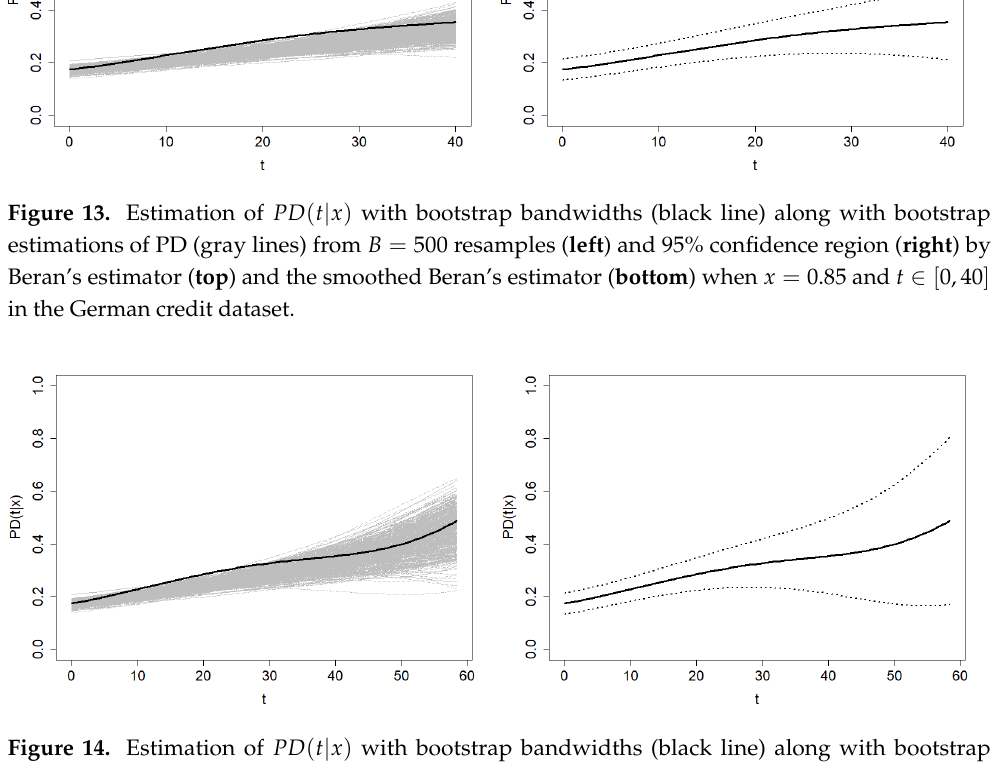
Figure 14. Estimation of PD ( t | x ) with bootstrap bandwidths (black line) along with bootstrap estimations of PD (gray lines) from B = 500 resamples ( left ) and 95% confidence region ( right ) by the smoothed Beran’s estimator when x = 0.85 and t ∈ [ 0,60 ] in the German credit